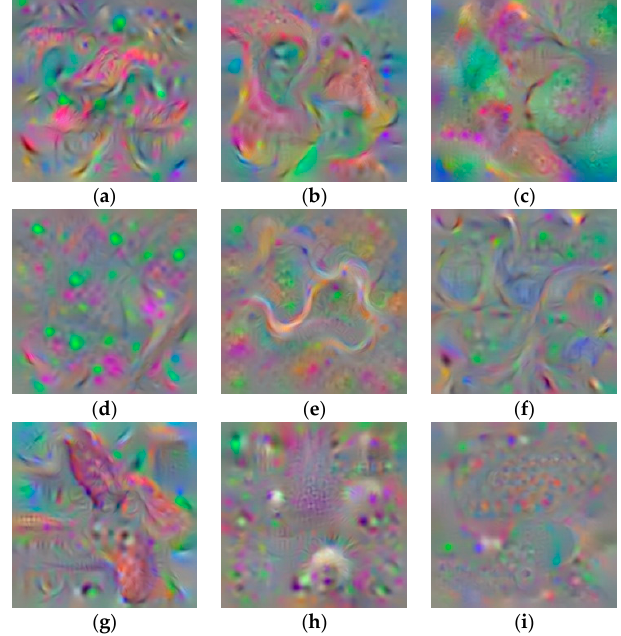
Figure 7. Deep feature maps visualization of diseases and pest ( a ) Canker; ( b ) Gray mold; ( c ) Leaf mold; ( d ) Low temperature; ( e ) Miner; ( f ) Nutritional excess; ( g ) Plague; ( h ) Powdery mildew; ( i ) Whitefly. Each feature map illustrates how our neural network system interprets a disease in the context after being classified by a SoftMax function.